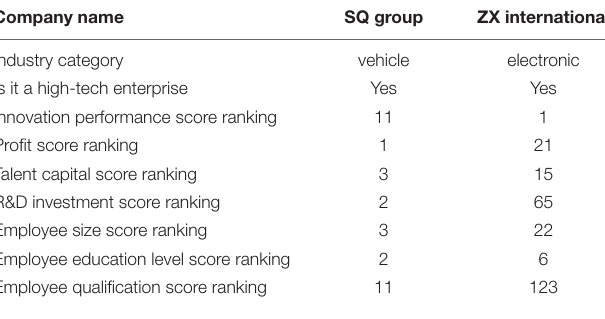
TABLE 4 | The score function of the factors in the first-level